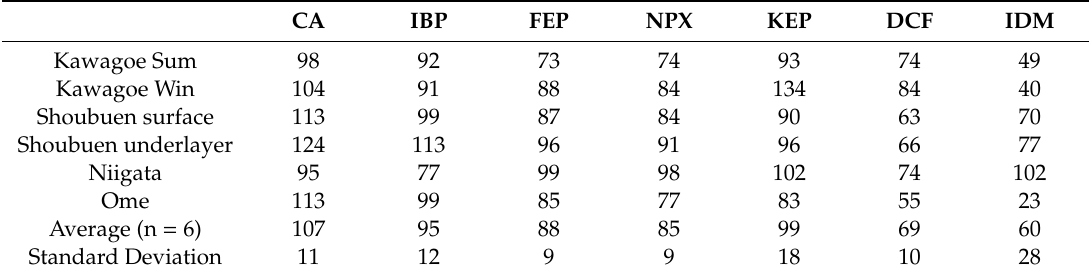
Table 1. The residual ratios (%) of pharmaceuticals in sterile slurry with the breathable sponge caps. CA IBP